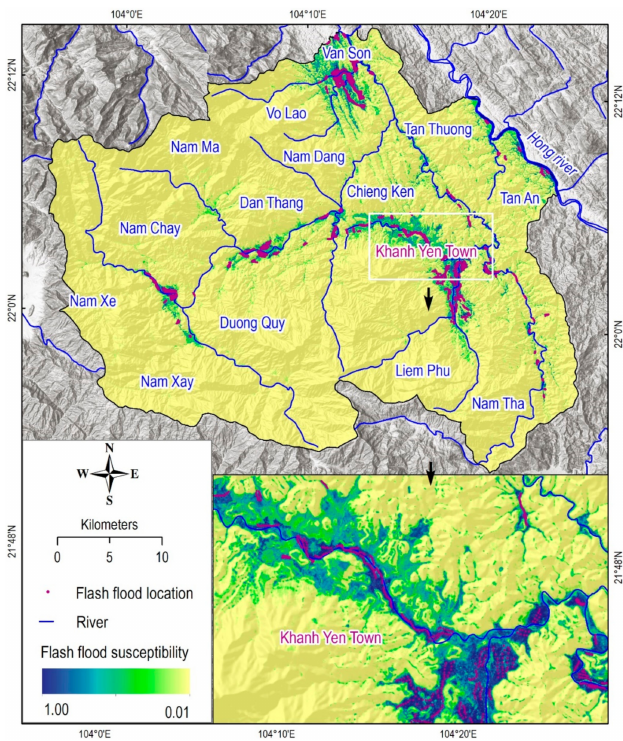
Figure 5. Flash flood susceptibility map of the Van Ban district using the proposed HFPS-RSTree